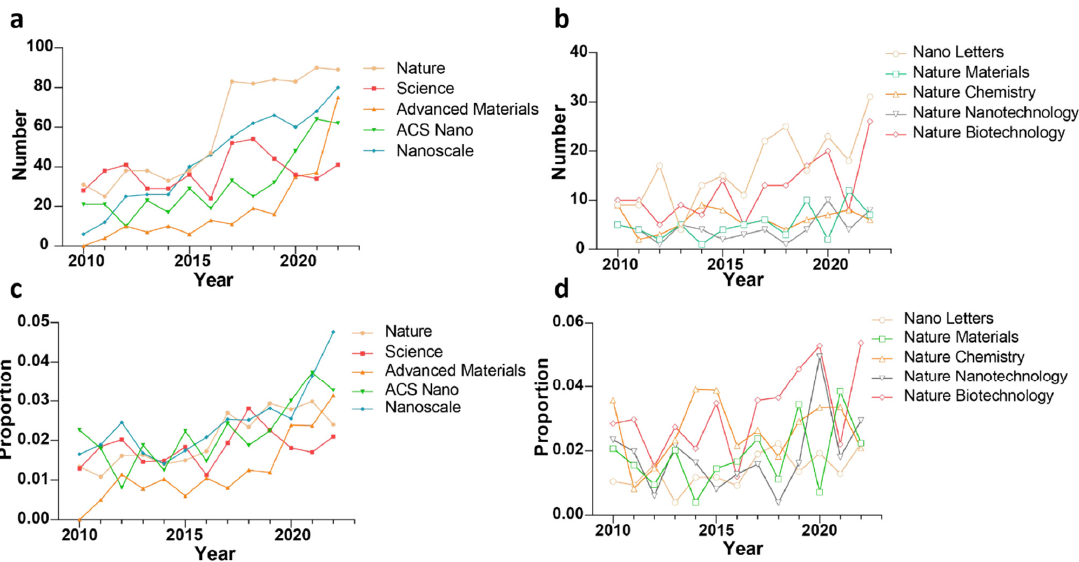
Figure 2. Number and proportion of articles related to computing published in important journals and journals in nano-field between 2010 and 2022. ( a , b ) Changes in the number of computing-related articles published from 2010 to 2022 in 10 journals. ( c , d ) Changes in the proportion of computing-related articles in total published articles from 2010 to 2022 in 10 journals.